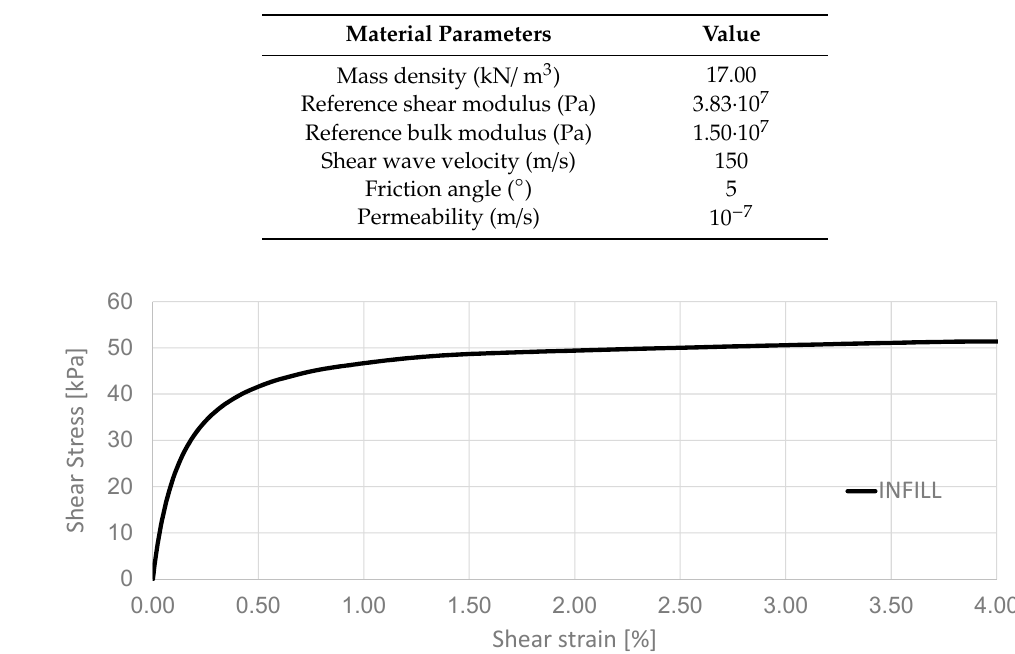
Table 7. Material parameters (infill soil).